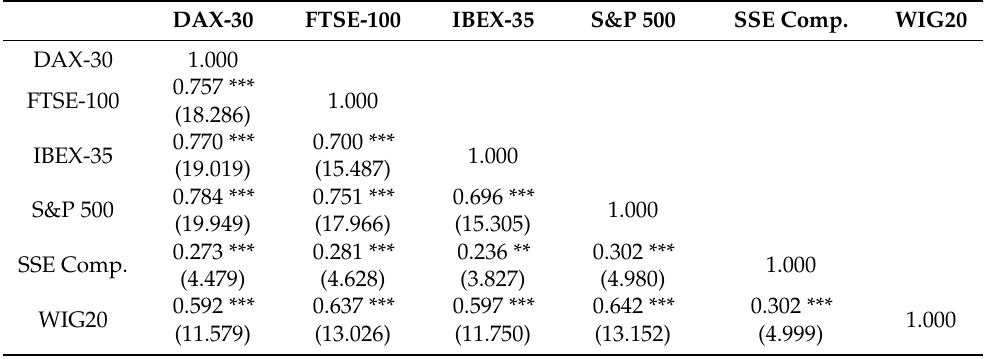
Table 2. Correlation level between log-returns of international stock